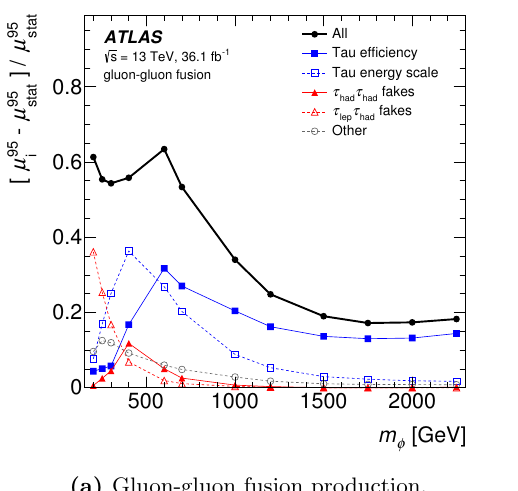
Figure 9. Impact of major groups of systematic uncertainties on the (cid:30) upper limits as a function of the scalar boson mass, separately for the (a) gluon-gluon fusion and (b) b -associated production